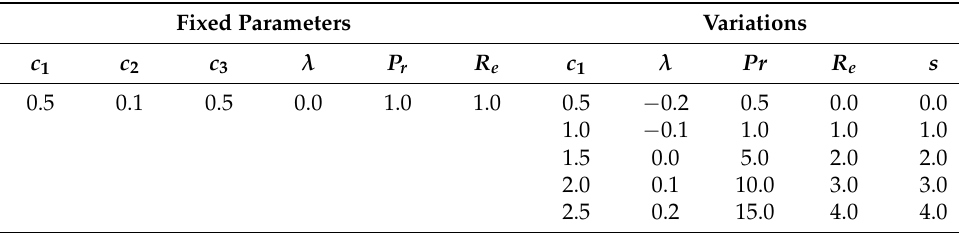
Table 1. The detailed overview of the cases studied in this paper. Fixed Parameters